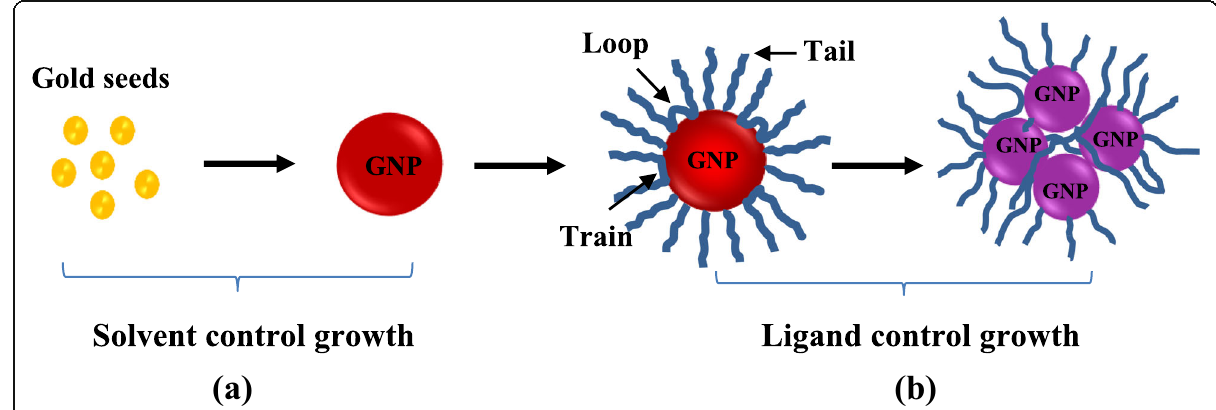
Fig. 3 Growth stages of GNPs in colloidal solution in presence of long polymer chain ligand molecules where the growth of GNPs is governed by ( a ) solvent molecules and ( b ) ligand